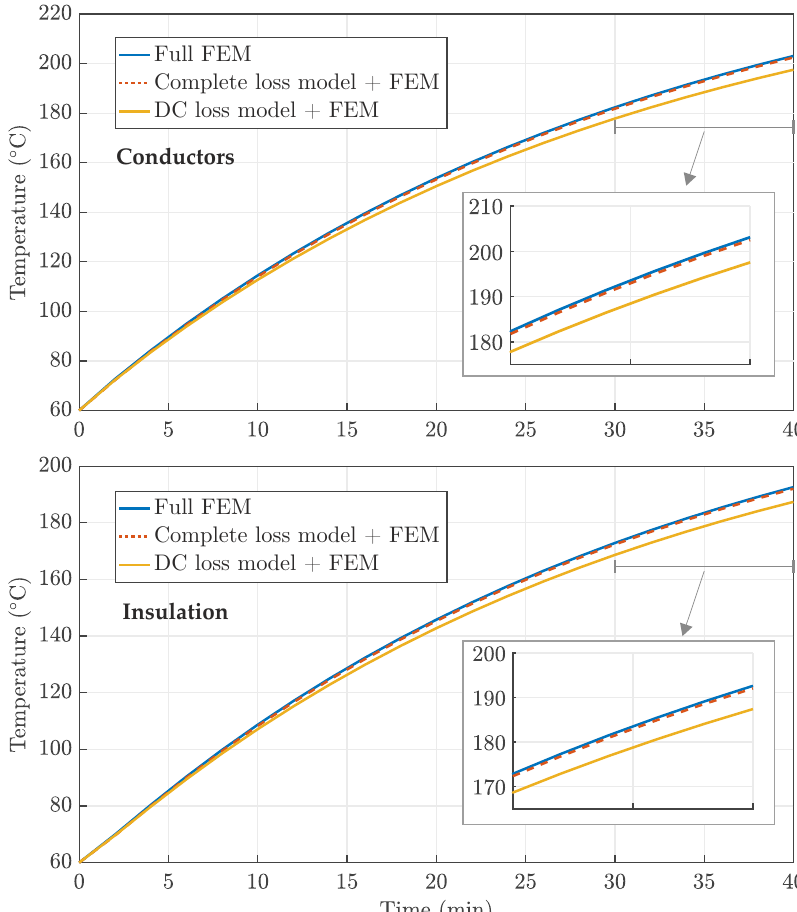
Figure 7. Temperature evolution in the conductors and insulations computed through different